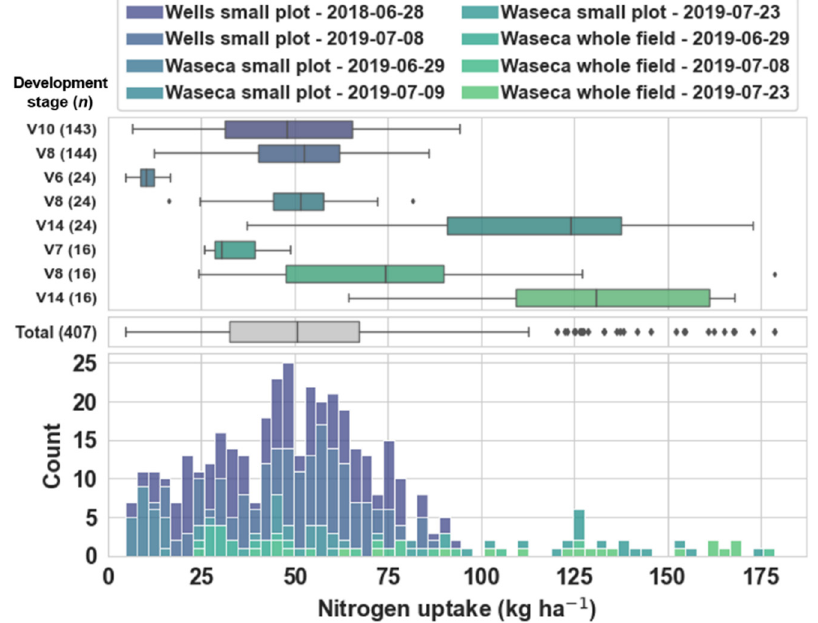
Figure 3. Boxplots and a stacked histogram of nitrogen uptake distribution expressed according to the experiment and date from which samples were collected. The boxplots are expressed both within experiment and date (upper boxplots) and across all experiments and dates (lower boxplot). The developmental stage and number of observations in each sample set is indicated on the left axis of the upper boxplots.